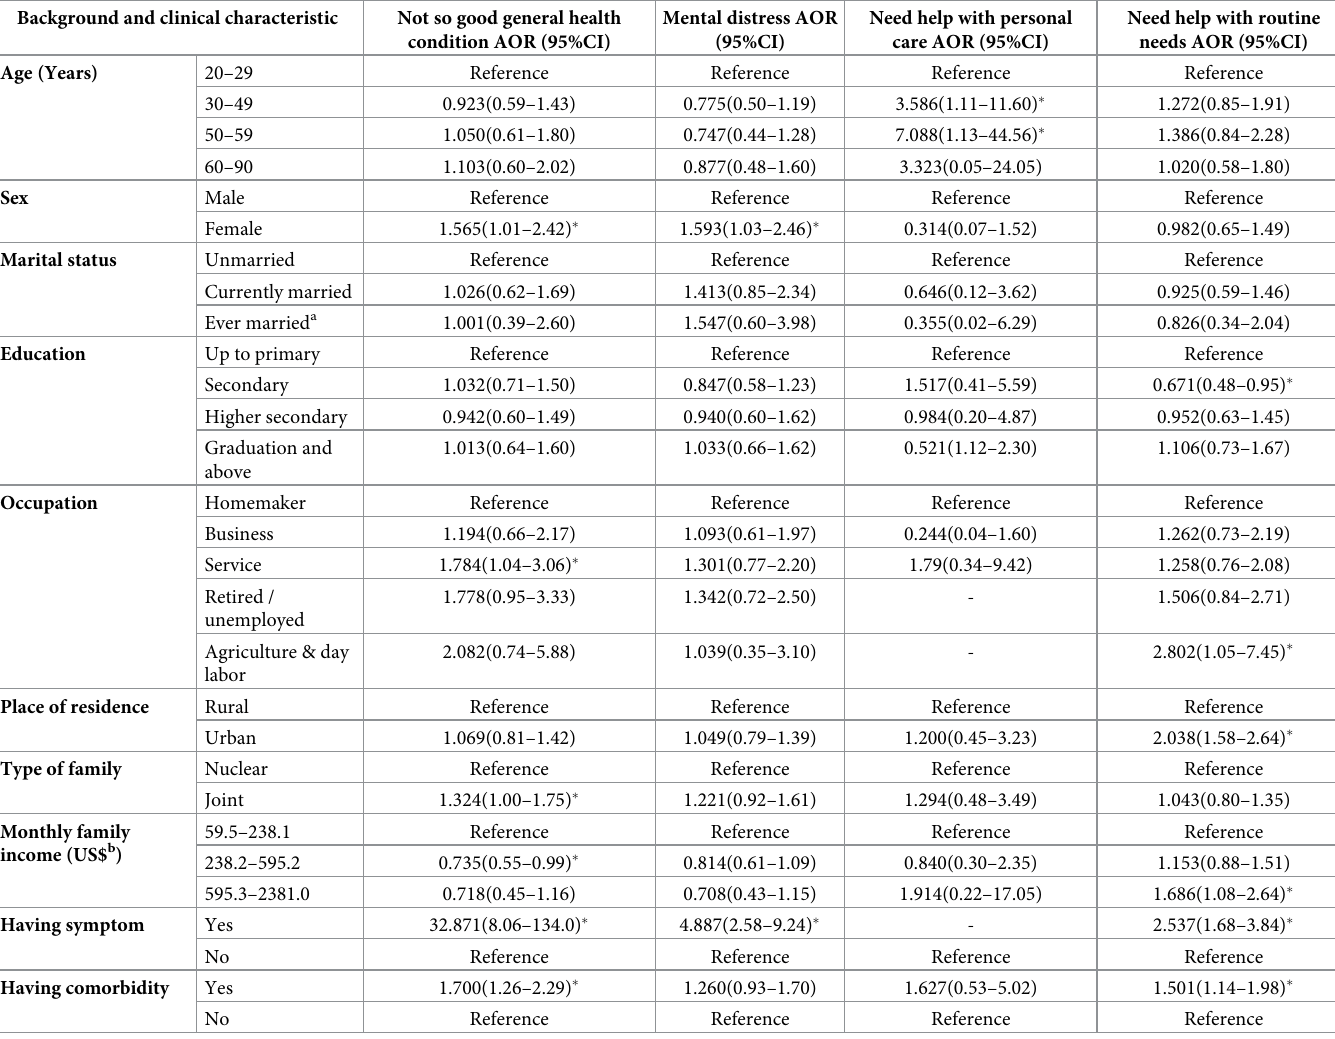
Table 3. Logistic regression analysis of items of HRQOL by background and clinical characteristics of the COVID-19 patients (n = 1204). Background and clinical